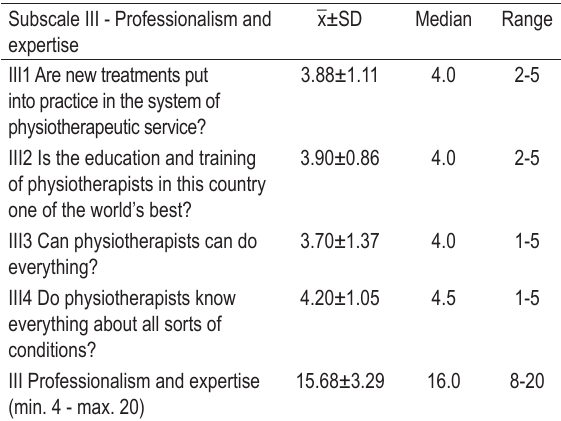
TABLE 4. Overview of mean scores – subscale III - Professionalism